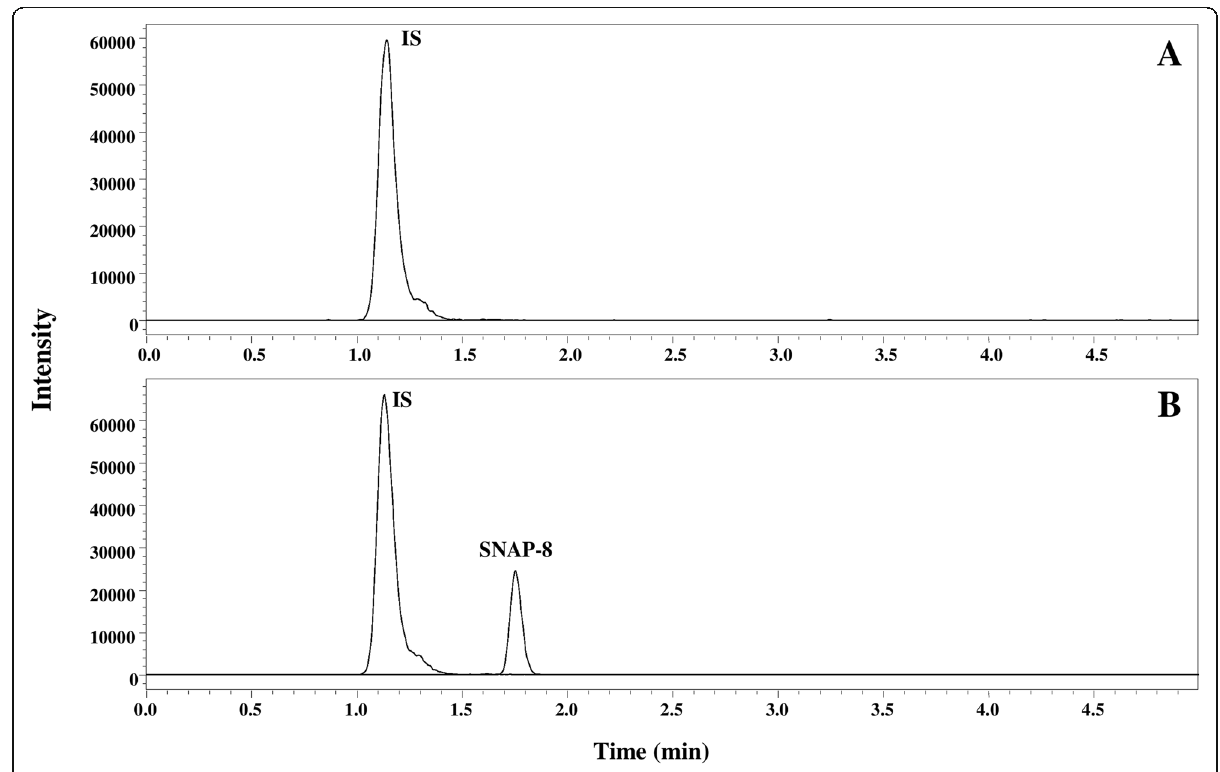
Fig. 4 MRM chromatograms of the blank spiked with IS ( a ) and SNAP-8 and IS ( b ) by